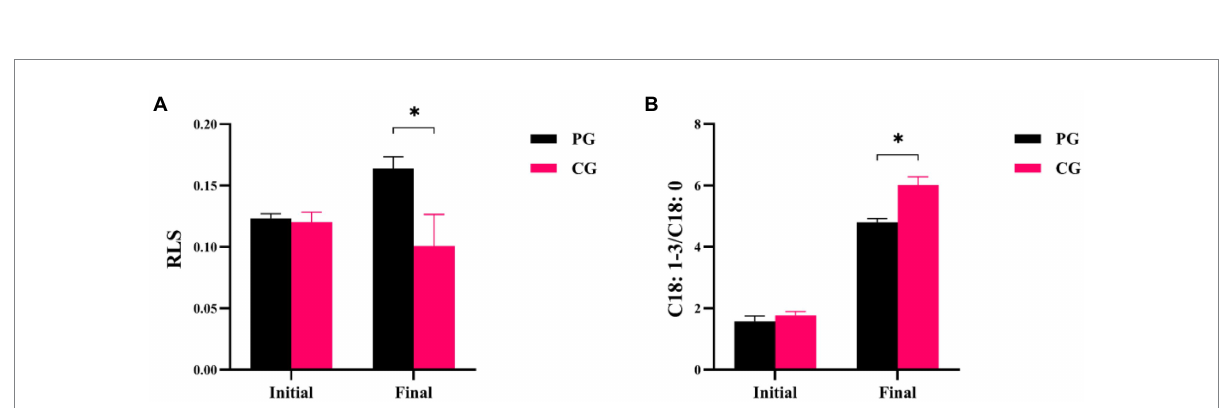
FIGURE 3 Differences in RLS (A) and C18: 1-3/C18: 0 (B) between PG and CG groups during the experimental period. “Initial” and “Final” indicate the initial and final stages of the experimental period, respectively. * indicates a significant difference between PG and CG groups ( p <